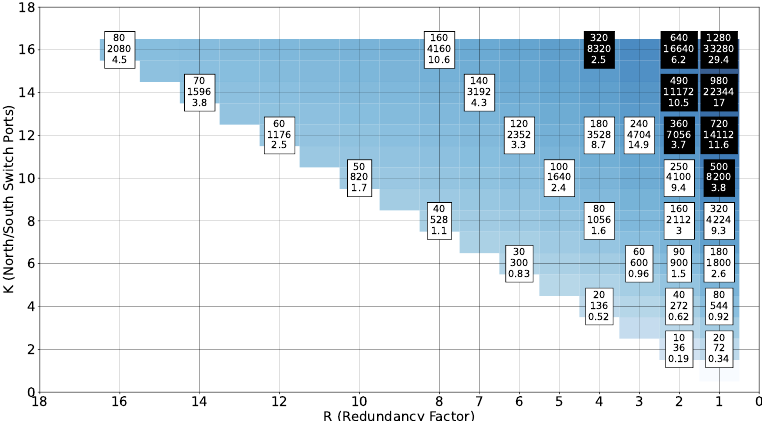
Figure 6. Number of VDs, number of interfaces, and startup times (in minutes) for Fat-Trees networks of increasing size. White boxes are obtained on a local virtual cluster. Black boxes are obtained on an Azure cluster.